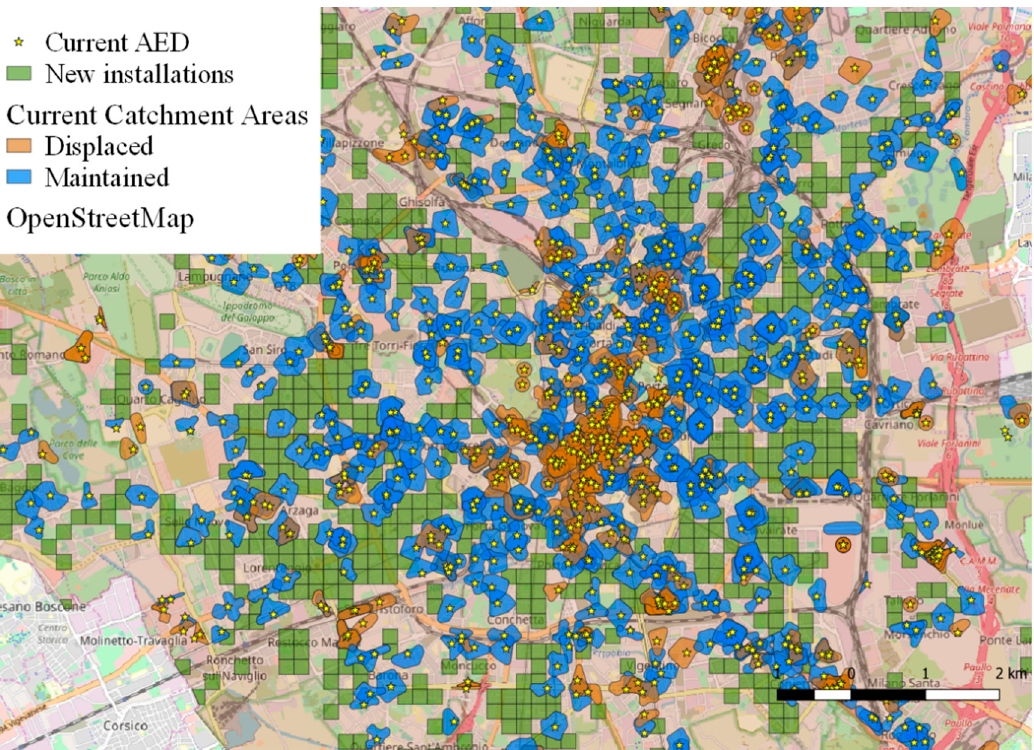
Figure 5. Example of the graphical representation of the output of the optimization strategy. Among currently available Automated External Defibrillators (AEDs), those that should be re-displaced (orange catchment areas) or not (blue catchment areas) are indicated, while the cells where the installation of a new device is suggested are depicted in green.